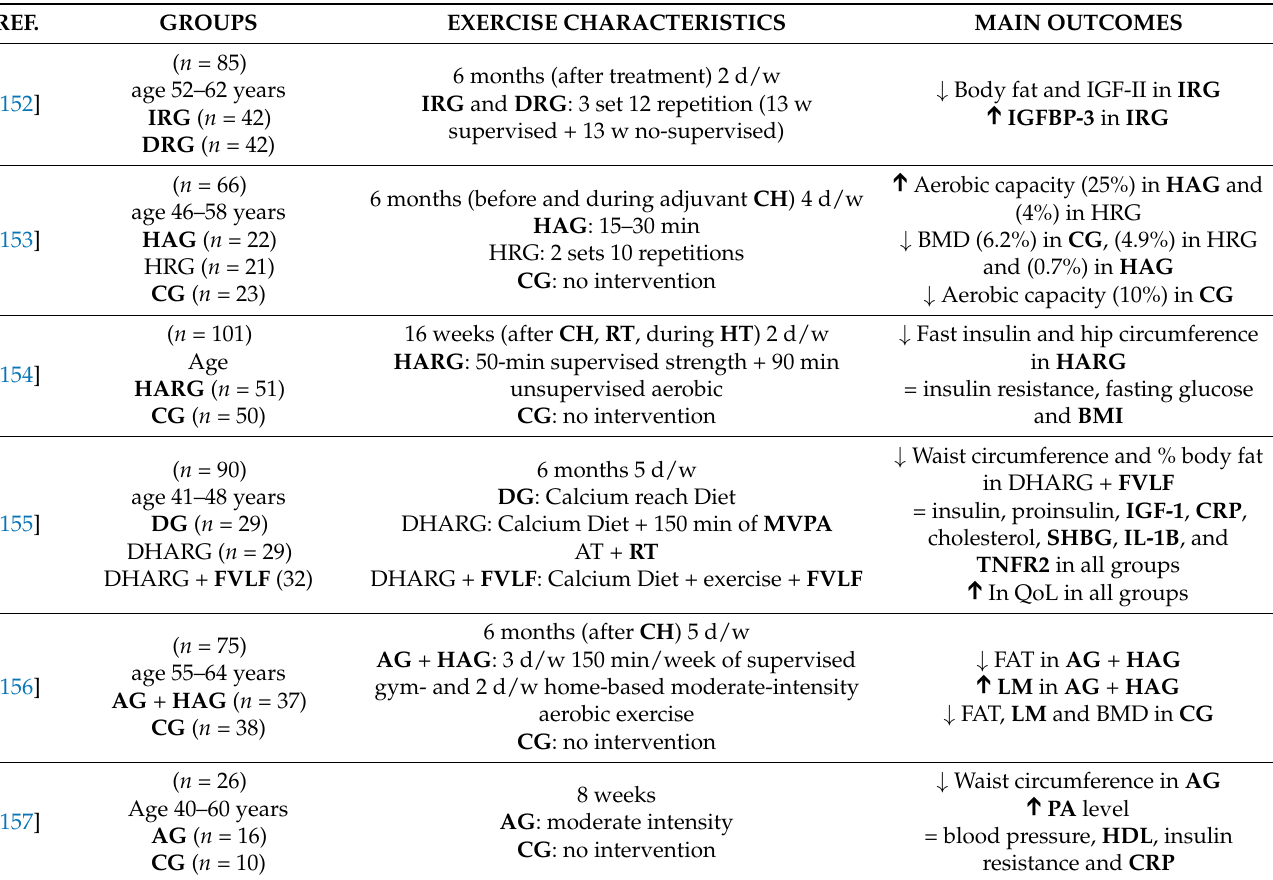
Table 3. Exercise and physical activity as secondary and tertiary prevention among ER+ breast cancer survivors before and during pharmacological treatments. REF.